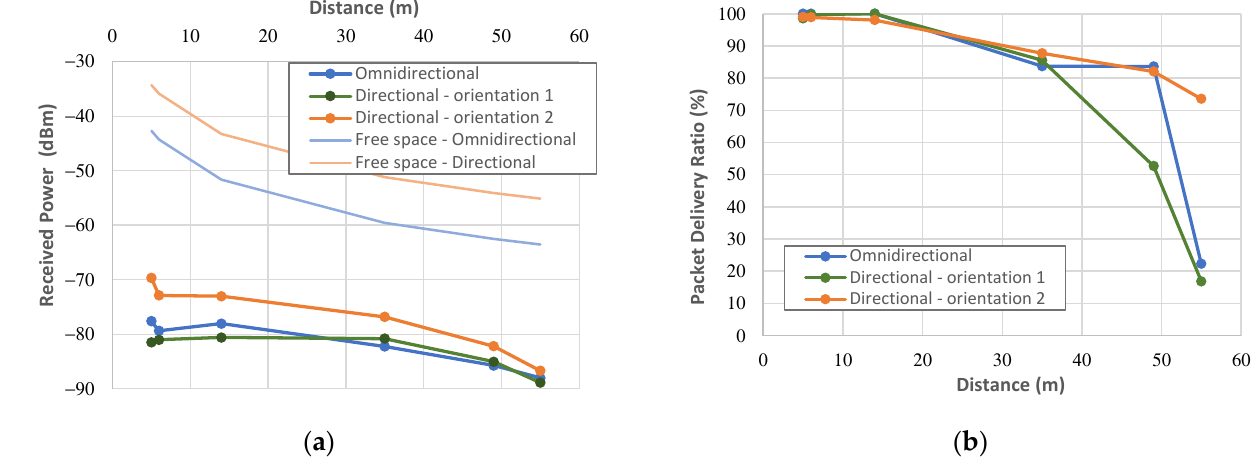
Figure 5. Measurements results of XBee for location 1: ( a ) average RSSI; ( b ) PDR.